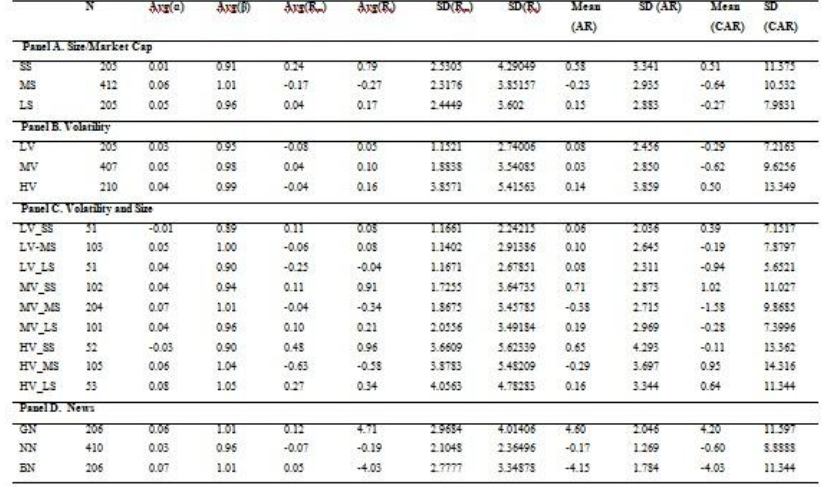
Table 4: Summary Statistics for the 822 quarterly announcements